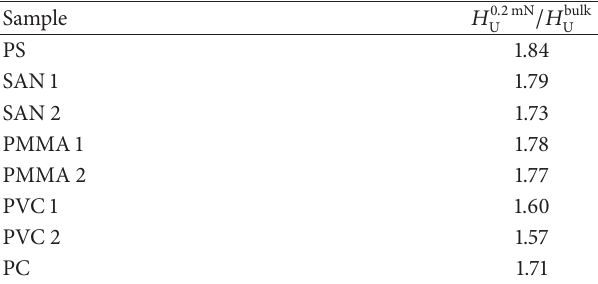
Figure 16: Universal hardness of thermoplastic polymers [28]. Table 2: 𝐻 0 . 2mN U /𝐻 bulk U ratio where 𝐻 0 . 2mN U and 𝐻 bulk U are, respec- tively, the universal hardness at 𝐹 max = 0.2 mN and large indentation depths